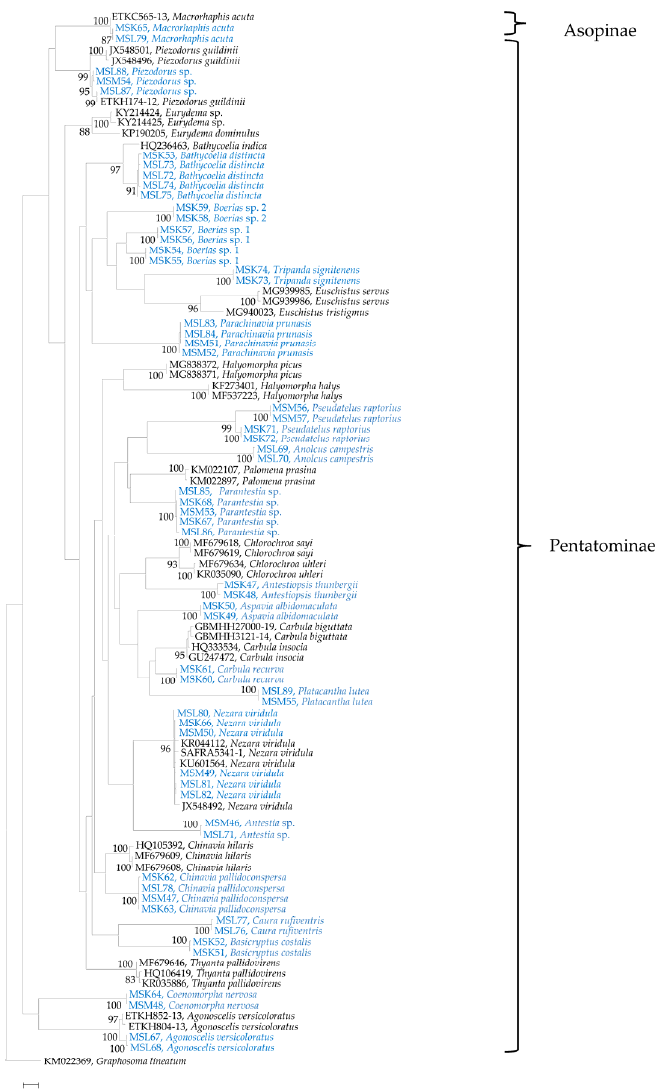
Figure 6. Maximum likelihood stink bug phylogeny based on the COI gene region. The specimens in blue represent species of stink bugs obtained from macadamia orchards in the KwaZulu-Natal, Limpopo and Mpumalanga provinces of South Africa in this study.